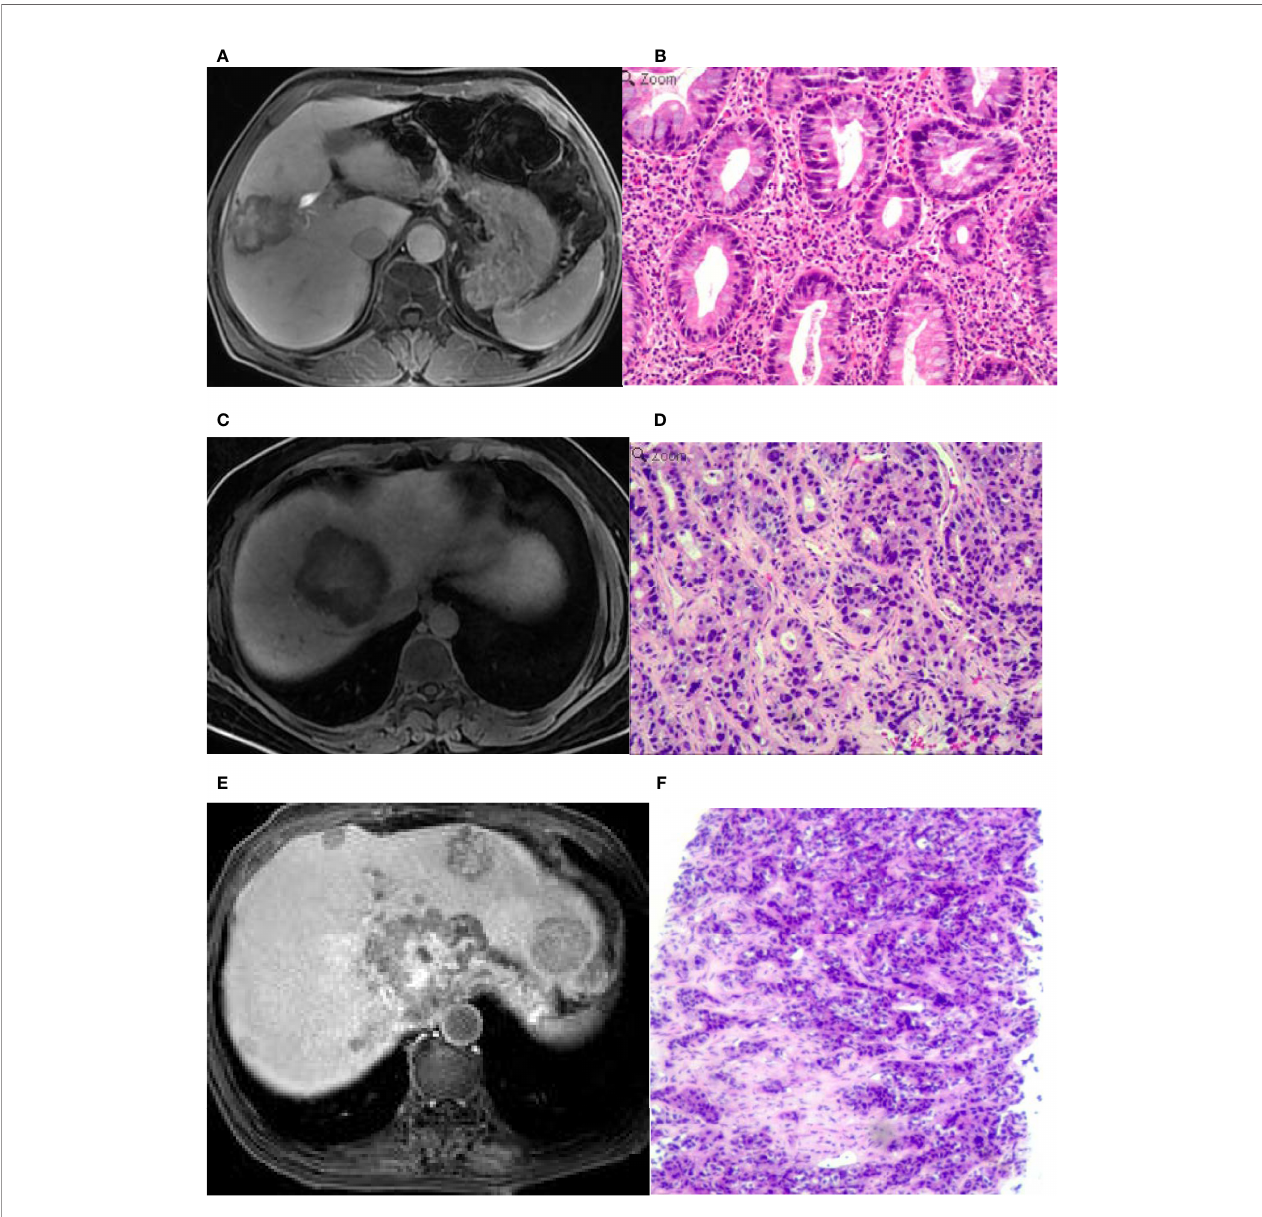
FIGURE 3 | An intrahepatic mass-forming cholangiocarcinoma (IMCC) lesion on magnetic resonance imaging (MRI) in the hepatobiliary phase (HBP) and in pathological staining. (A) A target sign was shown on the HBP image with an incomplete hypointense signal ring at the lesion edge. (B) Pathological staining showed that the IMCC lesion was poorly differentiated. (C) A target sign was shown on the HBP image, with a complete hypointense signal ring at the lesion edge. (D) Pathological staining demonstrated that the IMCC lesion was moderately-differentiated. (E) A target sign was shown on the HBP image with an incomplete hypointense signal ring at the lesion edge, and multiple metastases were seen in the liver, which also presented as a target sign. (F) Pathological staining showed that the IMCC lesion was poorly differentiated. Pathological staining: